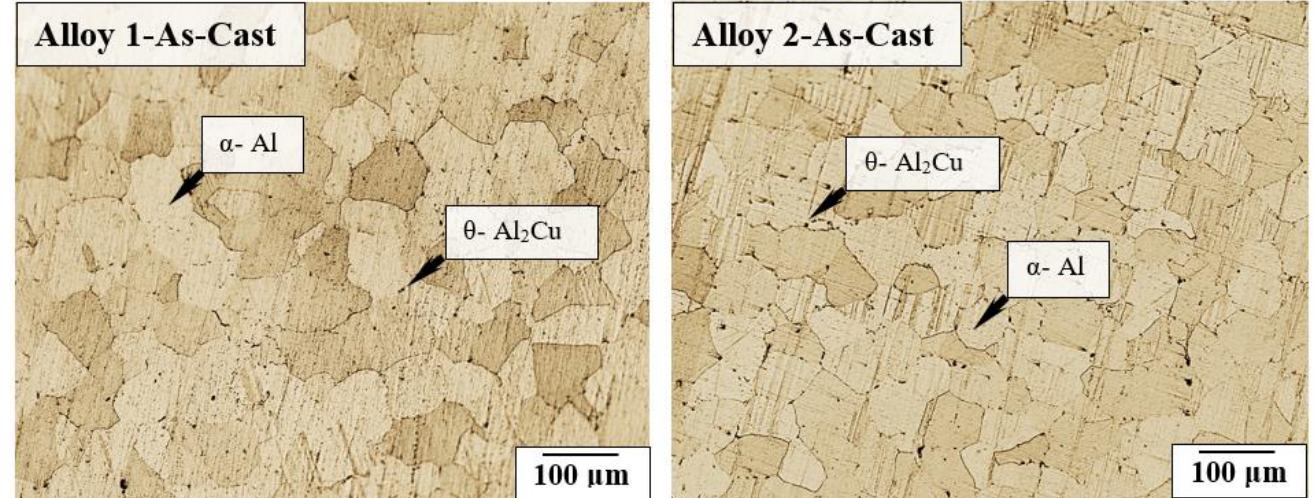
Figure 2. Cross-sectional optical microscopy (OM) observations of the as-cast state of the Al-Cu-Mg-Ag alloys, showing mainly the α -Al (matrix) and black-colored θ -Al 2 Cu (precipitates).